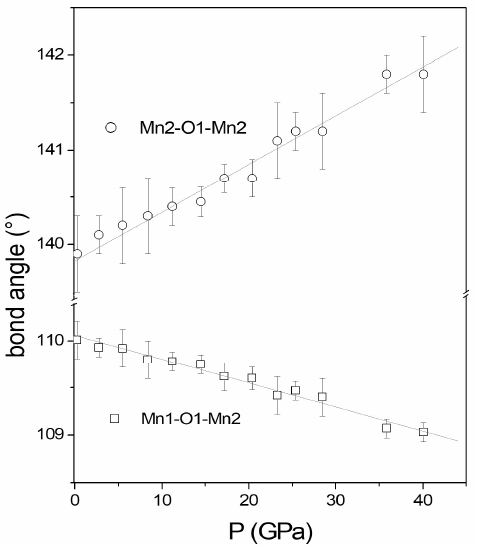
Figure 8. Mn-O-Mn bond angles in the 0–40 GPa pressure range. Mn2-O1-Mn2 monotonically evolves towards the 180° value, while Mn1-O1-Mn2 approaches 90°.